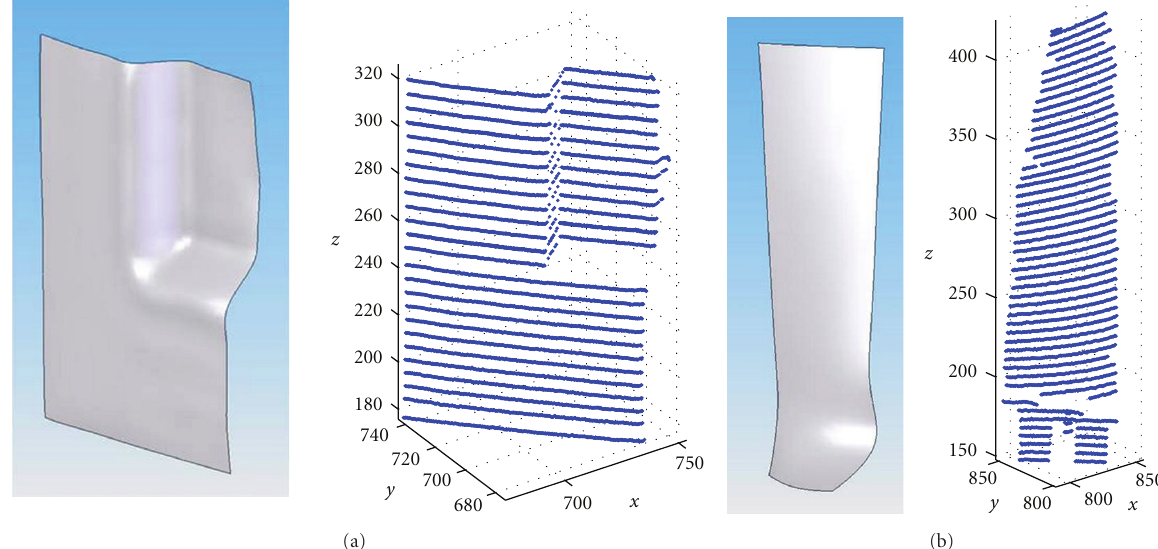
Figure 5: Cloud of points and relative surface reconstruction obtained for two test specimens.